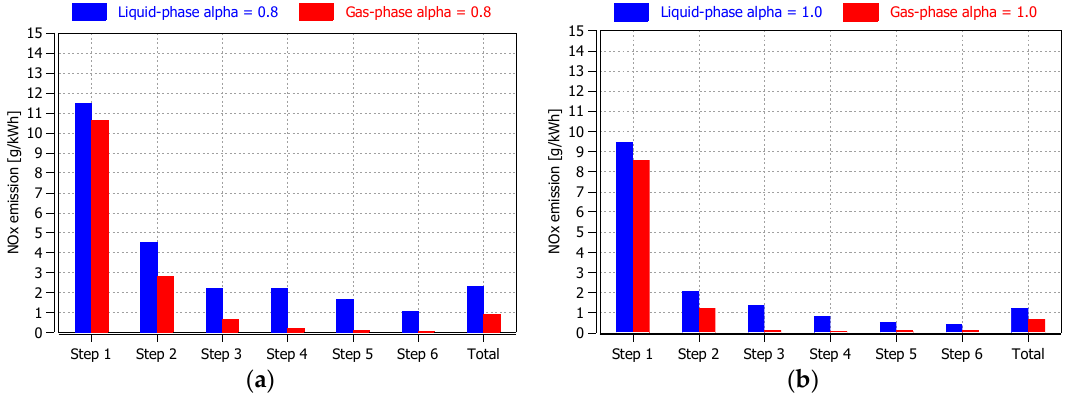
Catalysts 2017 , 7 , 307 Figure 3. NO x emission results for standard and gaseous urea dosing at α = 0.8 ( a ) and α = 1.0 ( b ).